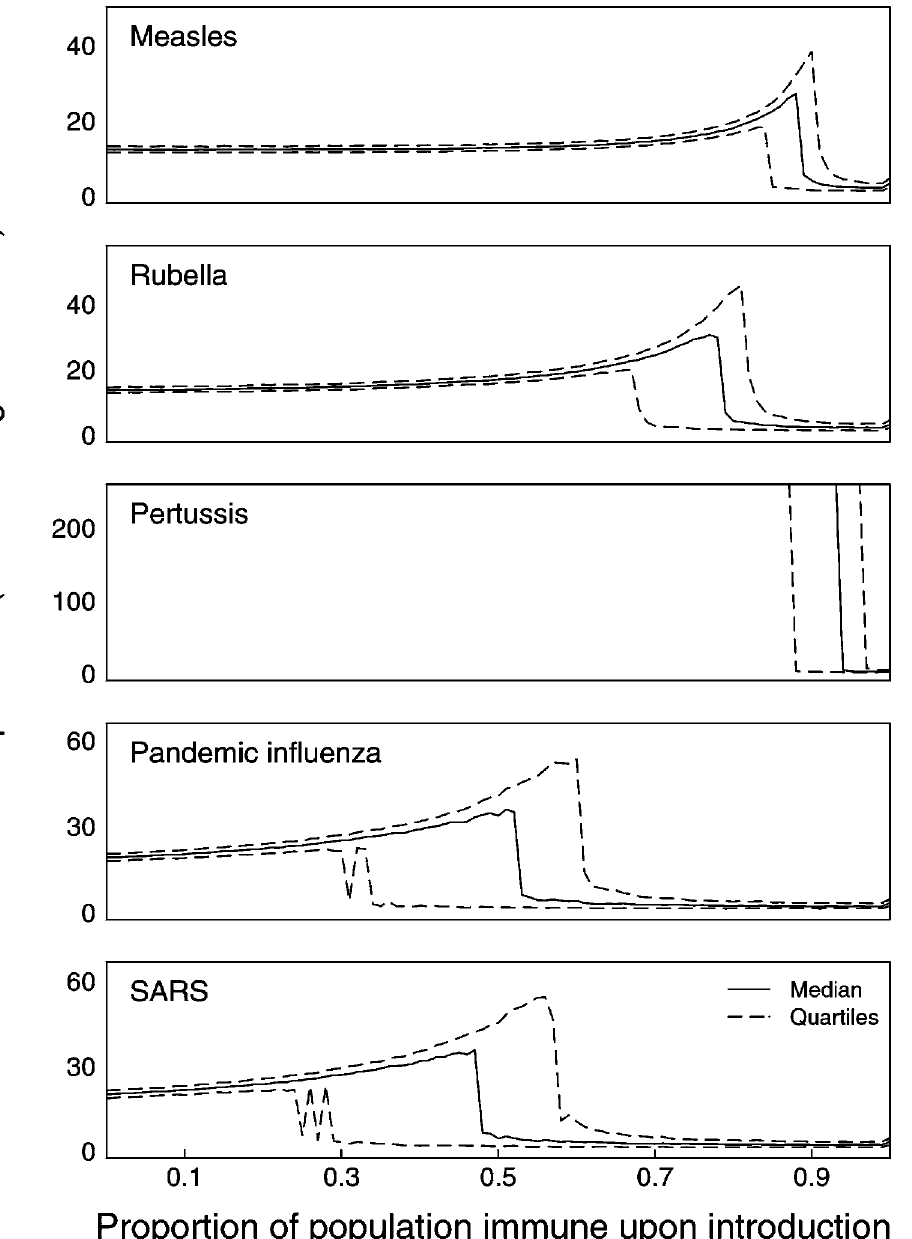
Figure 3. Enhancement of epidemic duration for diseases in human populations. Epidemic duration in a population of N =50,000 individuals for a variety of human pathogens as a function of population immunity at introduction. Solid lines show the median duration in disease generations for 1,000 simulation runs at each level of initial population immunity; dashed lines show quartiles. Each pathogen shows some level of enhancement of epidemic duration with increased immunity except pertussis. Enhancement of epidemic size is not observed for these pathogens for N